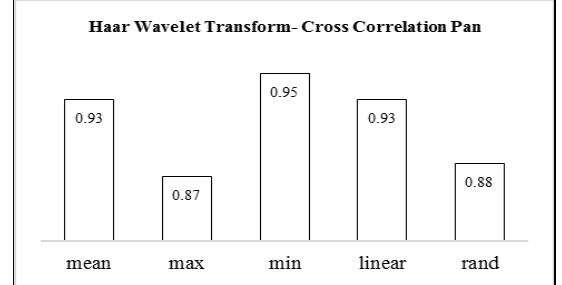
Figure 10. Cross correlation with PAN